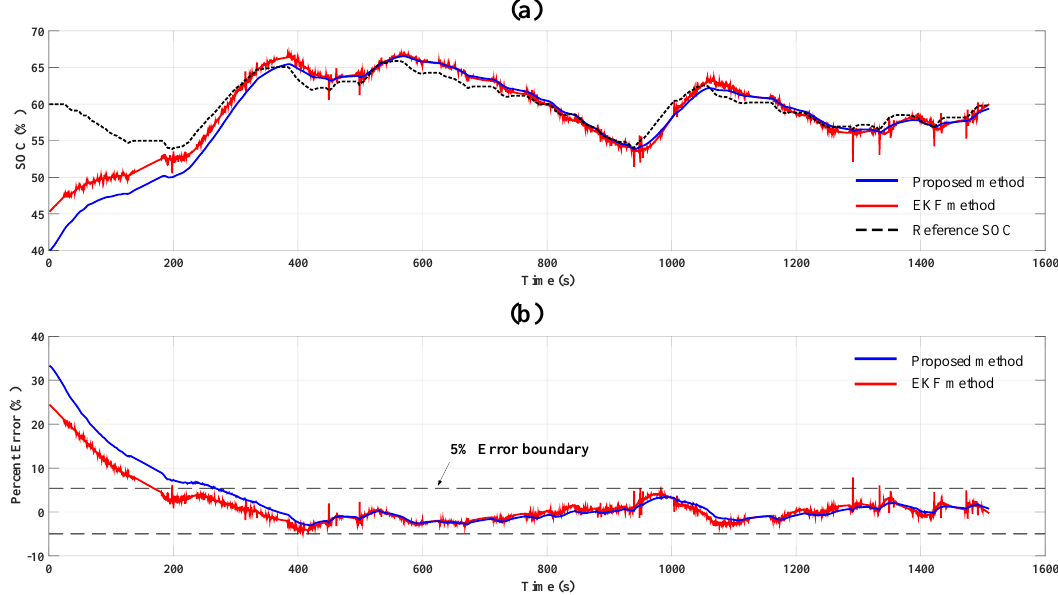
Figure 10. SOC estimation results under noiseless conditions: ( a ) SOC estimation results of the two types of methods and the ( b ) percentage error of each